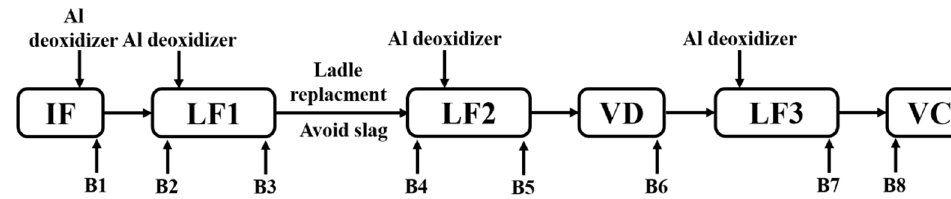
Figure 8. Schematic illustration of optimized metallurgical process and sampling. Table 4. Main chemical composition of slag specimens in the optimization process in mass%. Specimen No.